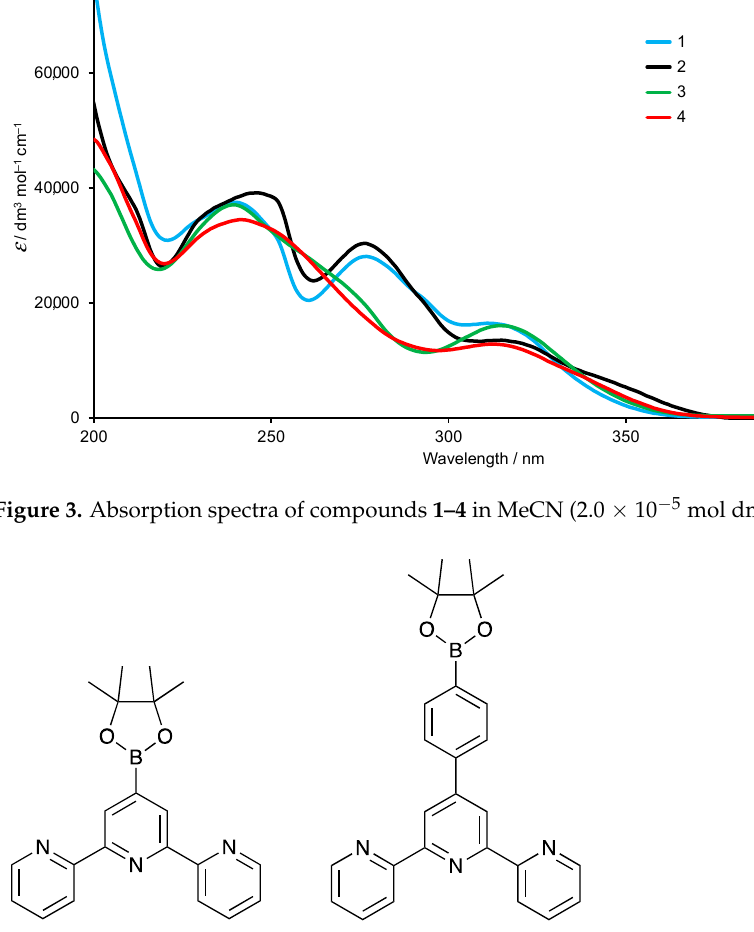
Figure 4. The structures of ( a ) 3 , ( b ) 4 and ( c ) 2 with ellipsoids plotted at 50% probability level and H atoms omitted for clarity. Selected bond parameters: in 3 : C11–Br1 = 1.8950(16) Å, C12–O1 = 1.365(2), O1–C22 = 1.429(2), C9–O2 = 1.367(2), O2–C23 = 1.424(2) Å, C12–O1–C22 = 116.40(14), C9– O2–C23 = 117.14(14)°; in 4 : C10–Br1 = 1.898(2), O1–C11 = 1.358(2), O1–C22 = 1.426(3), O2–C8 = 1.370(2), O2–C23 = 1.437(2) Å, C11–O1–C22 = 117.91(17), C8–O2–C23 = 117.08(16)°; in 2 : C19–B1 = 1.561(2), O3–B1 = 1.361(2), O4–B1 = 1.364(2), O1–C17 = 1.3714(18), O1–C28 = 1.4278(18), O2–C20 = 1.3682(18), O2–C29 = 1.4226(19), O3–C22 = 1.4676(19), O4–C23 = 1.4643(19) Å, C17–O1–C28 = 117.28(12), C20–O2–C29 = 117.62(12), O4–B1–C19 = 119.46(14), O3–B1–O4 = 113.21(14), O3–B1–C19 = 127.33(15)°. A trans,trans- conformation of the 2,2 ′ :6 ′ ,2 ″ -tpy unit is observed in 2 (Figure 4c), typi- cal of non-coordinated tpy ligands. The conformation of the 3,2 ′ :6 ′ ,3 ″ -tpy unit in 3 (Figure 4a) is one of three possible, limiting planar conformations (Scheme 5) and appears to be adopted in the crystal structure of 3 because of the assembly of the centrosymmetric motif shown in Figure 5. This features a combination of face-to-face π -stacking of pyridine rings containing N3 and N1 i (symmetry code i = 2 − x , 1 − y , 1 − z ) and C23–H23...N1 i hydrogen (a) (b) (c)